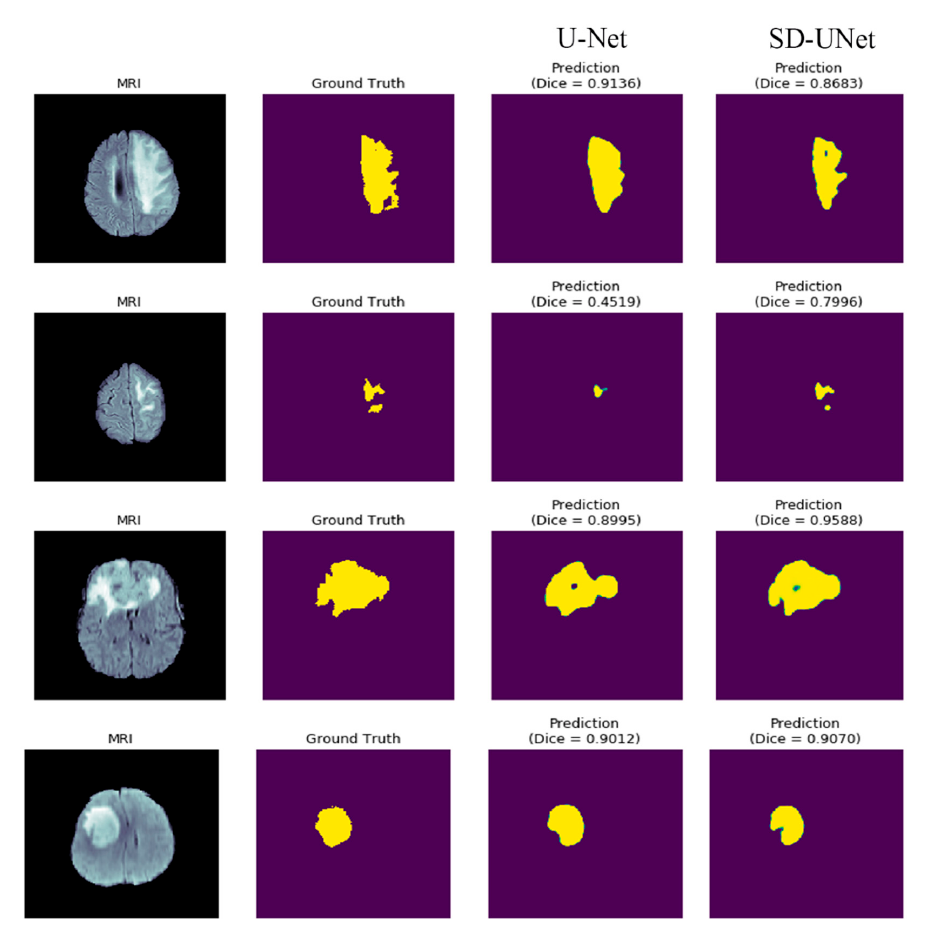
Figure 11. Sample Segmentation results on sample images from our test split. SD-UNet significantly performs better than U-Net on smaller tumors. The green-colored regions are simply a function of the plots that specify edges and show regions around the segmentation that are not part of the background.